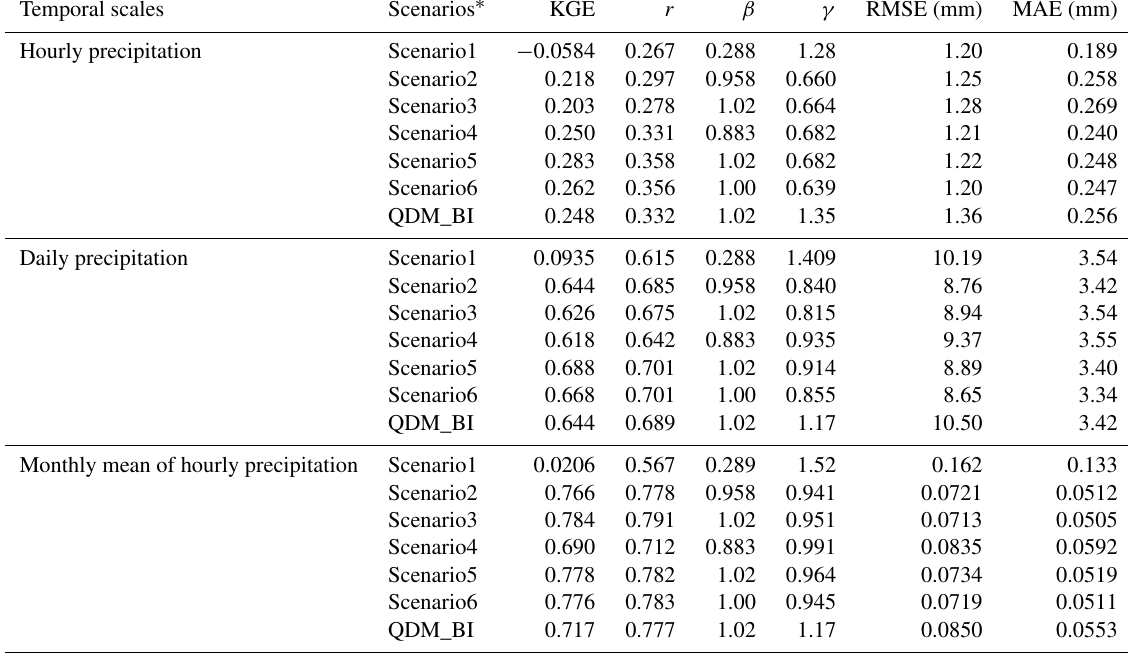
Table 3. Overall assessment for hourly, daily total, and monthly mean of hourly precipitation. KGE represents the modified Kling-Gupta efficiency (KGE) and it includes three components (correlation component r , bias component β and variability component γ ). The correlation component r is represented by the correlation coefficient, the bias component β is represented by the ratio of estimated and observed means, and the variability component γ is represented by the estimated and observed coefficients of